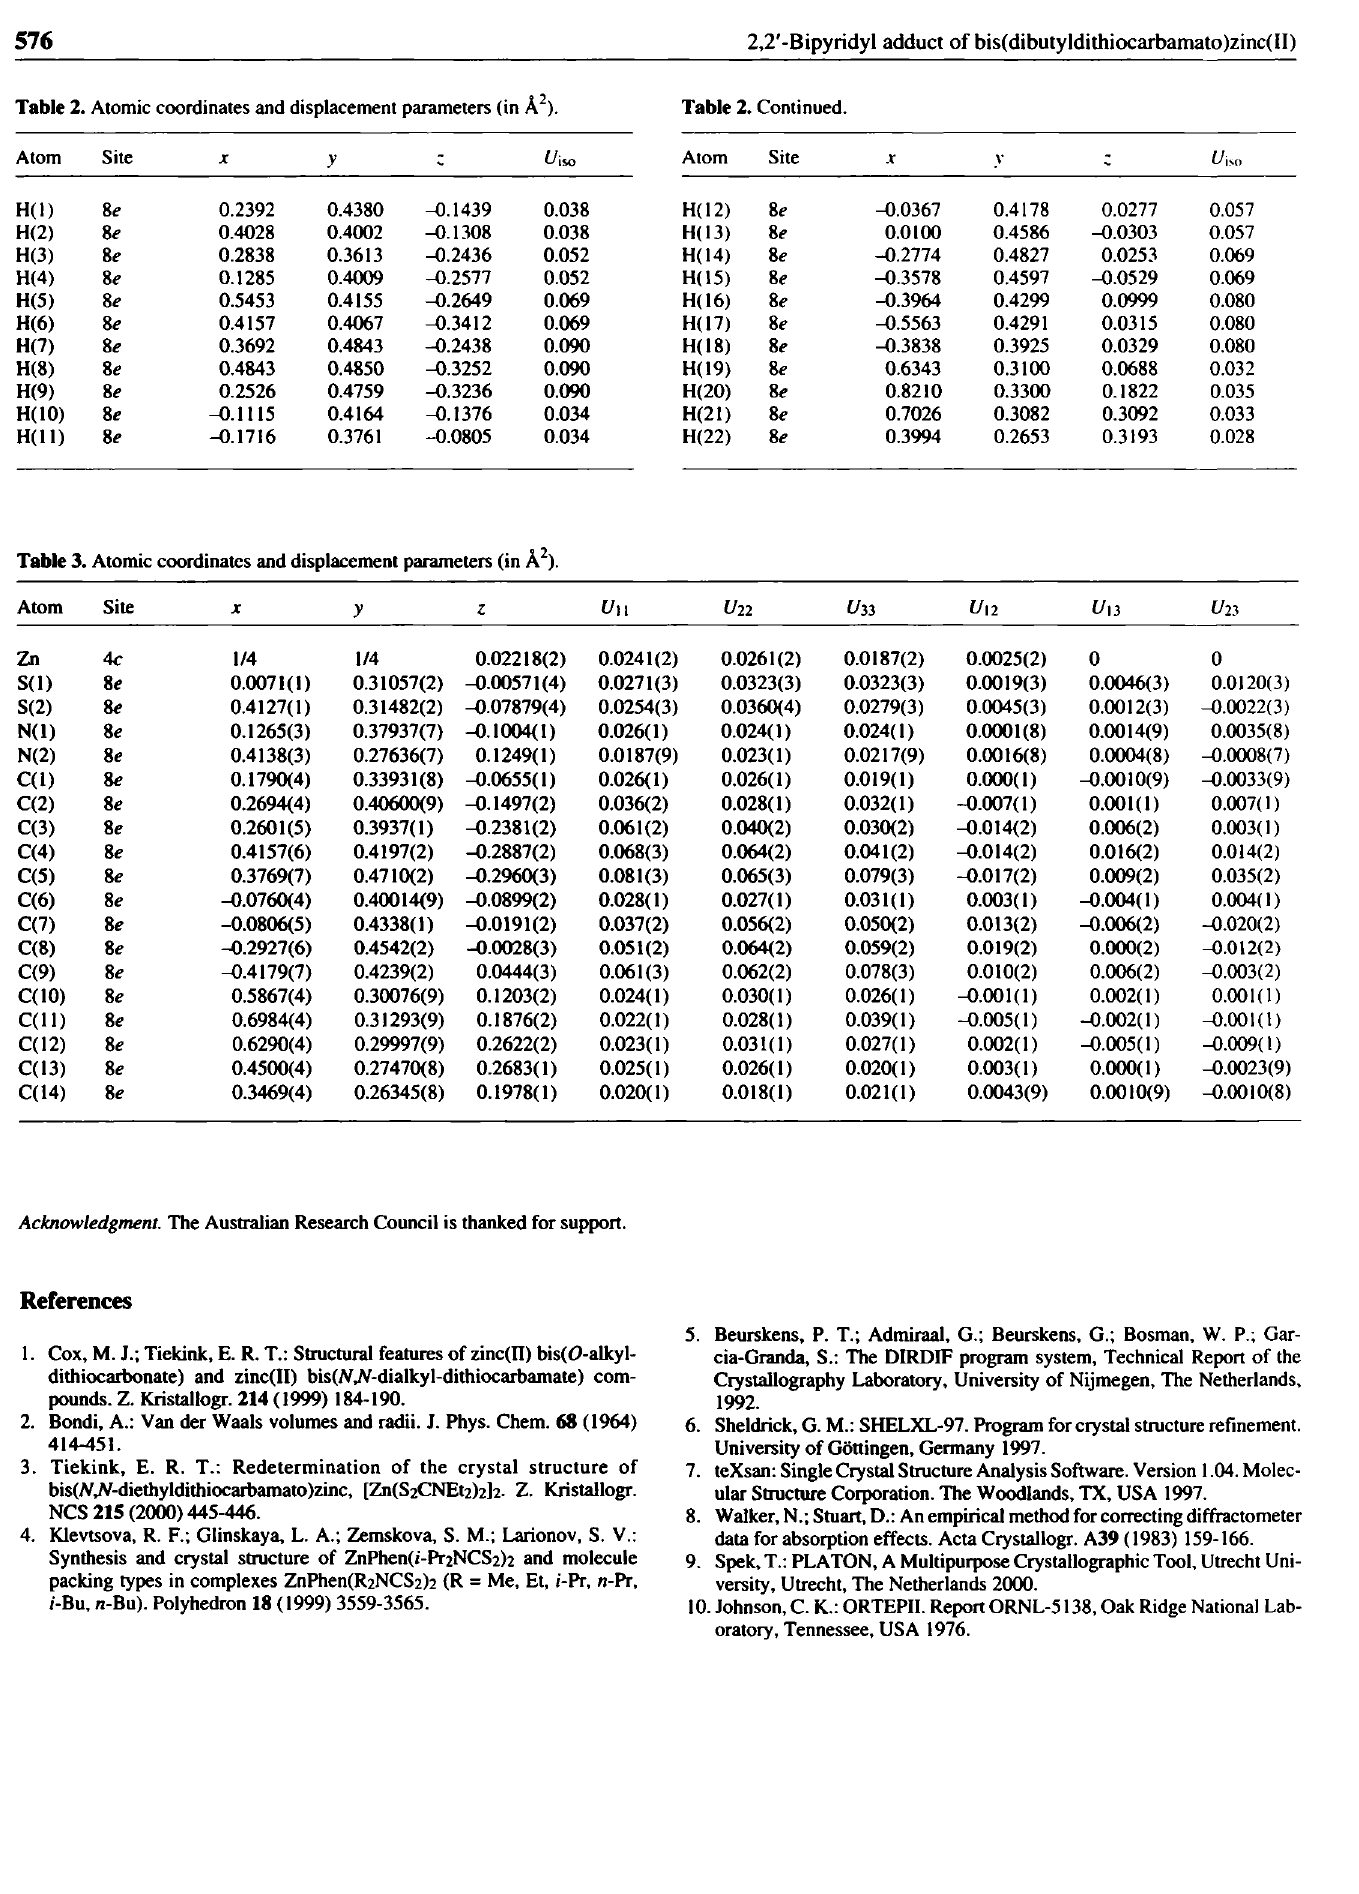
Table 2. Atomic coordinates and displacement parameters (in A 2 ). Table 2. Continued.